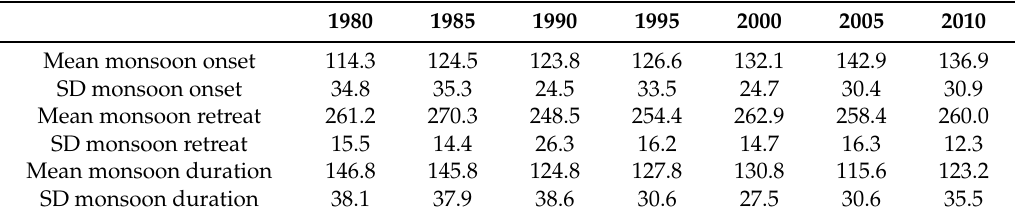
Figure 8. Yearly average monsoon duration is noted by the black connected line. Each grey dot on the graph shows the monsoon duration for each province in each year in the sample, upon which the yearly average was calculated. Table 2. Five year mean and standard deviation values for monsoon onset, retreat, and